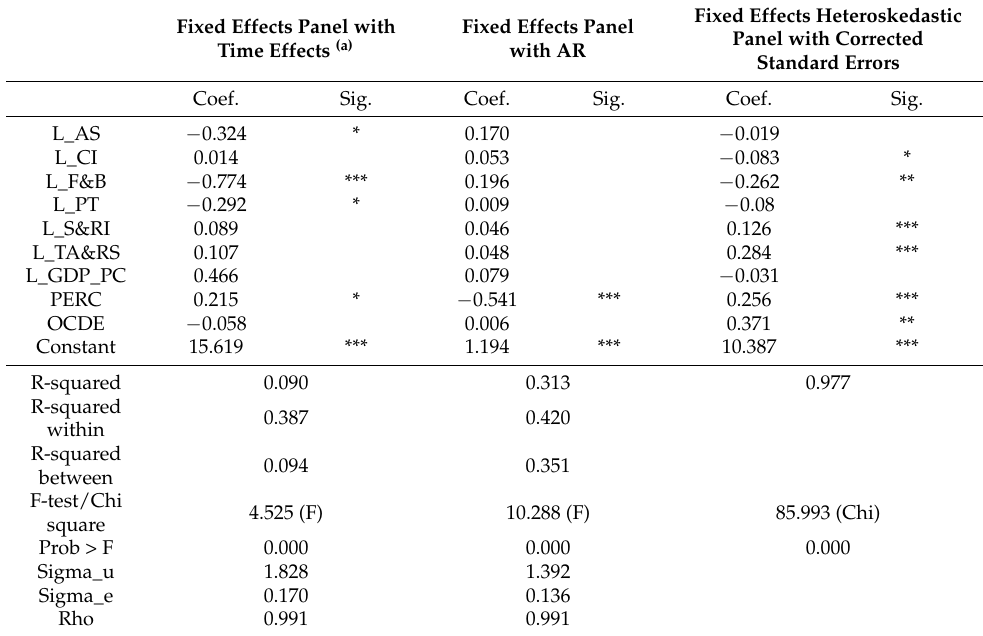
Table 3. Fixed effects panel data estimations for tourism receipts (in logarithm) for the countries in the sample (The full estimations, together with confidence intervals, can be found in the Appendix A (Tables